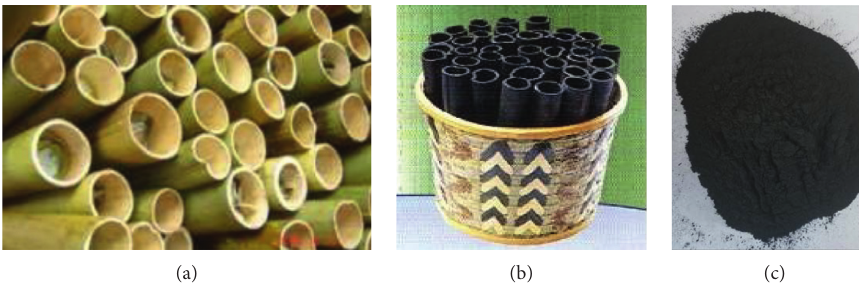
Figure 2: Charcoal powder extraction from raw bamboo